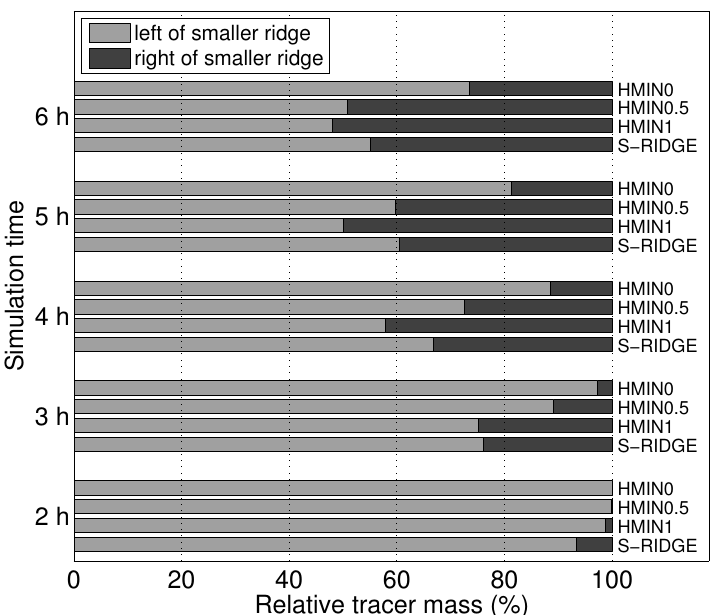
Figure 12. Relative tracer mass located left (light gray) and right (dark gray) of the first ridge ( x = − 13 . 9km) as a function of time. A tracer has been constantly emitted at the foot of the mountain range ( − 23 km ≤ x ≤ − 22km, see Fig. 11). Shown are the simulations HMIN0, HMIN0.5, HMIN1, and S-RIDGE between 2 and 6h of